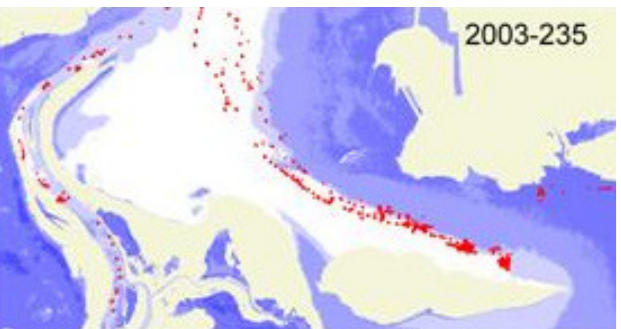
Figure 3. Water turbidity (blue = clear, white = turbid) and distribution of vessels (red dots) in Northern Poyang Lake, China (Courtesy Wu